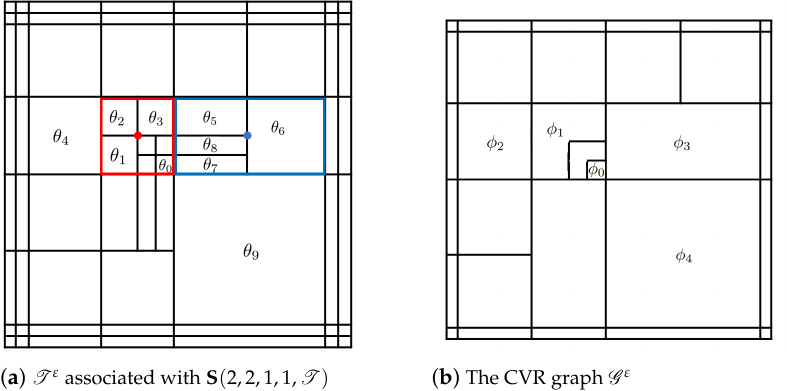
Figure 4. An example of the modified hierarchical T-mesh and its CVR graph. “ • ” denotes the domain-center of T-rectangle domain in the red box; “ • ” denotes the the domain-centre of the T-rectangle domain in the green box. Table 1. Some notations for modified hierarchical T-meshes and the corresponding CVR graphs